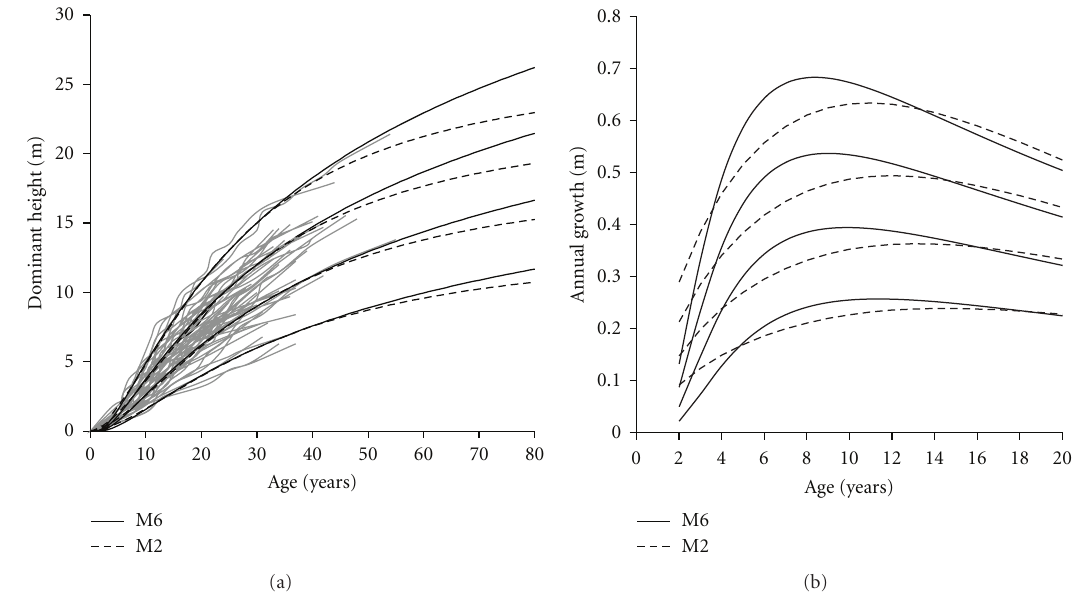
Figure 5: Height growth curves for site index values of 6, 9, 12 and 15 m at reference age of 30 years overlaying the trajectories of the observed heights over time for models M2 and M6 (left) and current annual height growth curves derived for both models